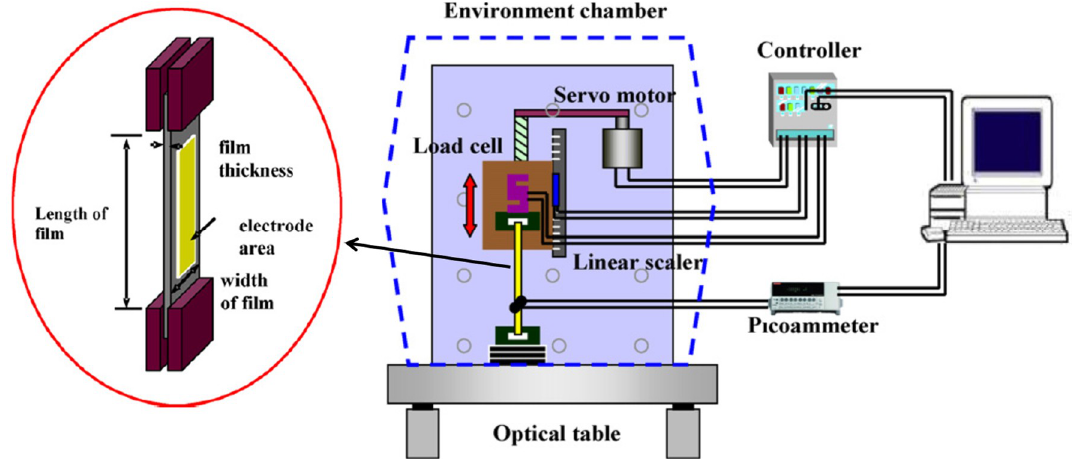
Figure 2. Schematic of piezoelectric charge constant measurement based on direct piezoelectricity [31]. The effect of directionality on the piezoelectric charge constant of EAPap was investigated by considering three different orientations, as shown in Figure 3.